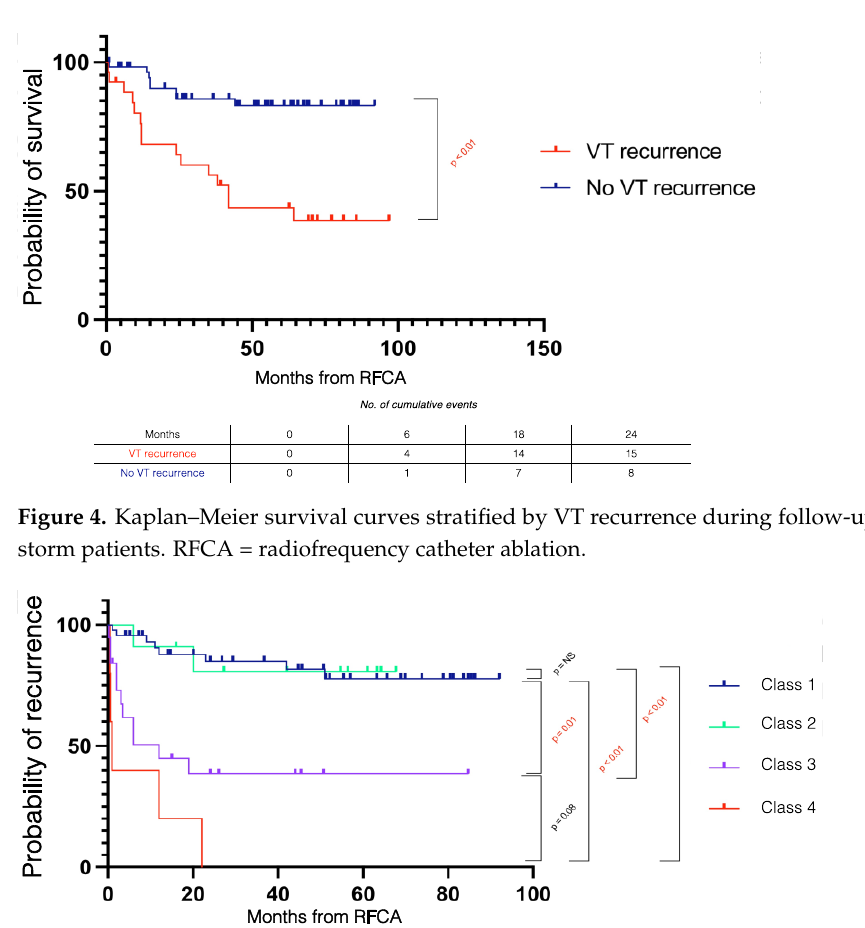
Figure 3. Kaplan – Meier survival curves stratified by combined procedural outcomes in electrical storm patients. RFCA = radiofrequency catheter ablation.